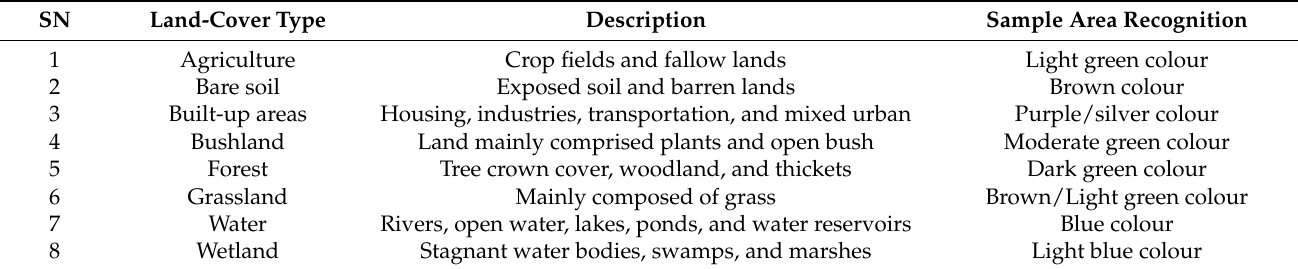
Table 3. The land-cover types targeted for